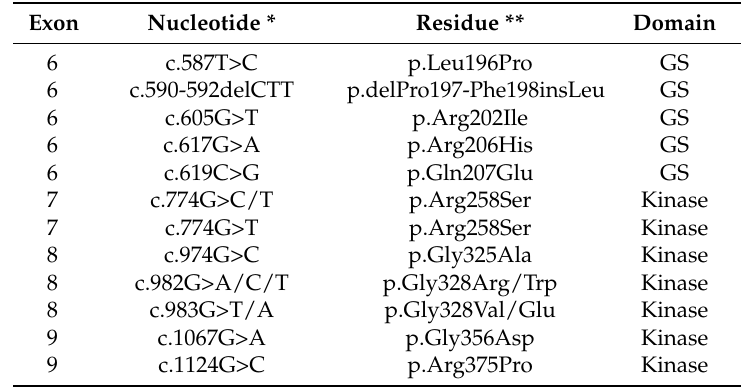
Table 1. ACVR1 mutations associated with